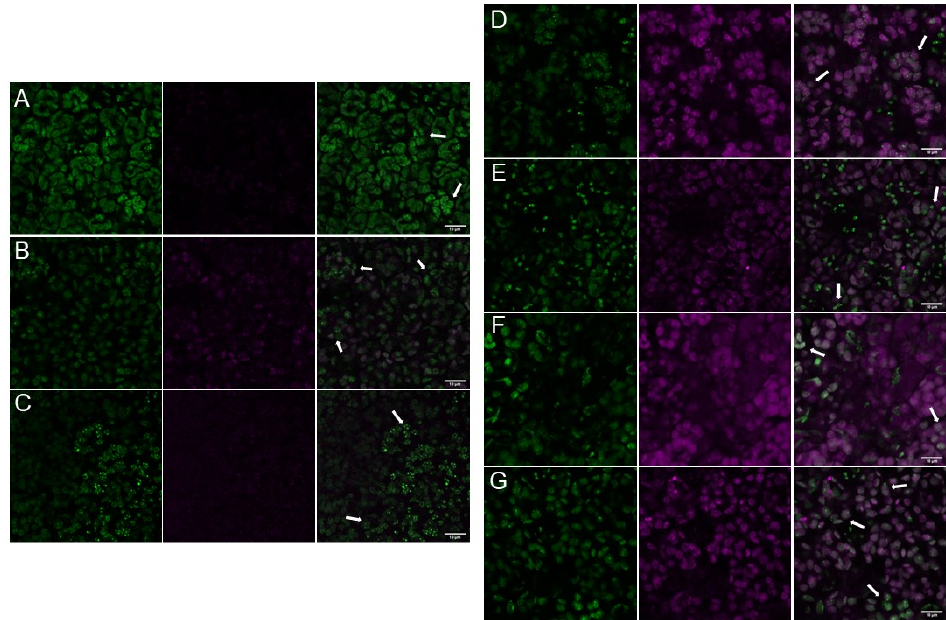
Figure 2. PII foci formation in Arabidopsis thaliana under different temperature and light regimes. Expression of genomic At PII-GFP under the control of the pUBQ10 promotor ( pUBQ10::AtPII cDNA - GFP ) was analyzed in 6-day-old seedlings. Seedlings were incubated for 24 h for temperature treatment in the dark at ( A ) RT, ( B ) 8 °C, ( C ) 37 °C, and for light treatment in ( D ) blue light, ( E ) green light, ( F ) red light, and ( G ) far red light. Seedlings were fixed after incubation. In each row, the GFP fluorescence is shown first, chlorophyll autofluorescence is shown second, and the merge of both pictures is shown last. White arrows: PII foci. Scale bar: 10 µm.